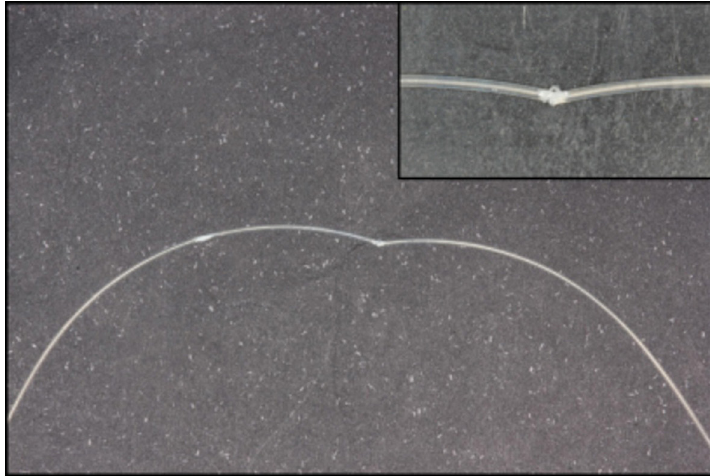
Figure 5- Crack generated on the FRP archwire during deflection (Optis/TP Orthodontics ® ; La Porte, Indiana,